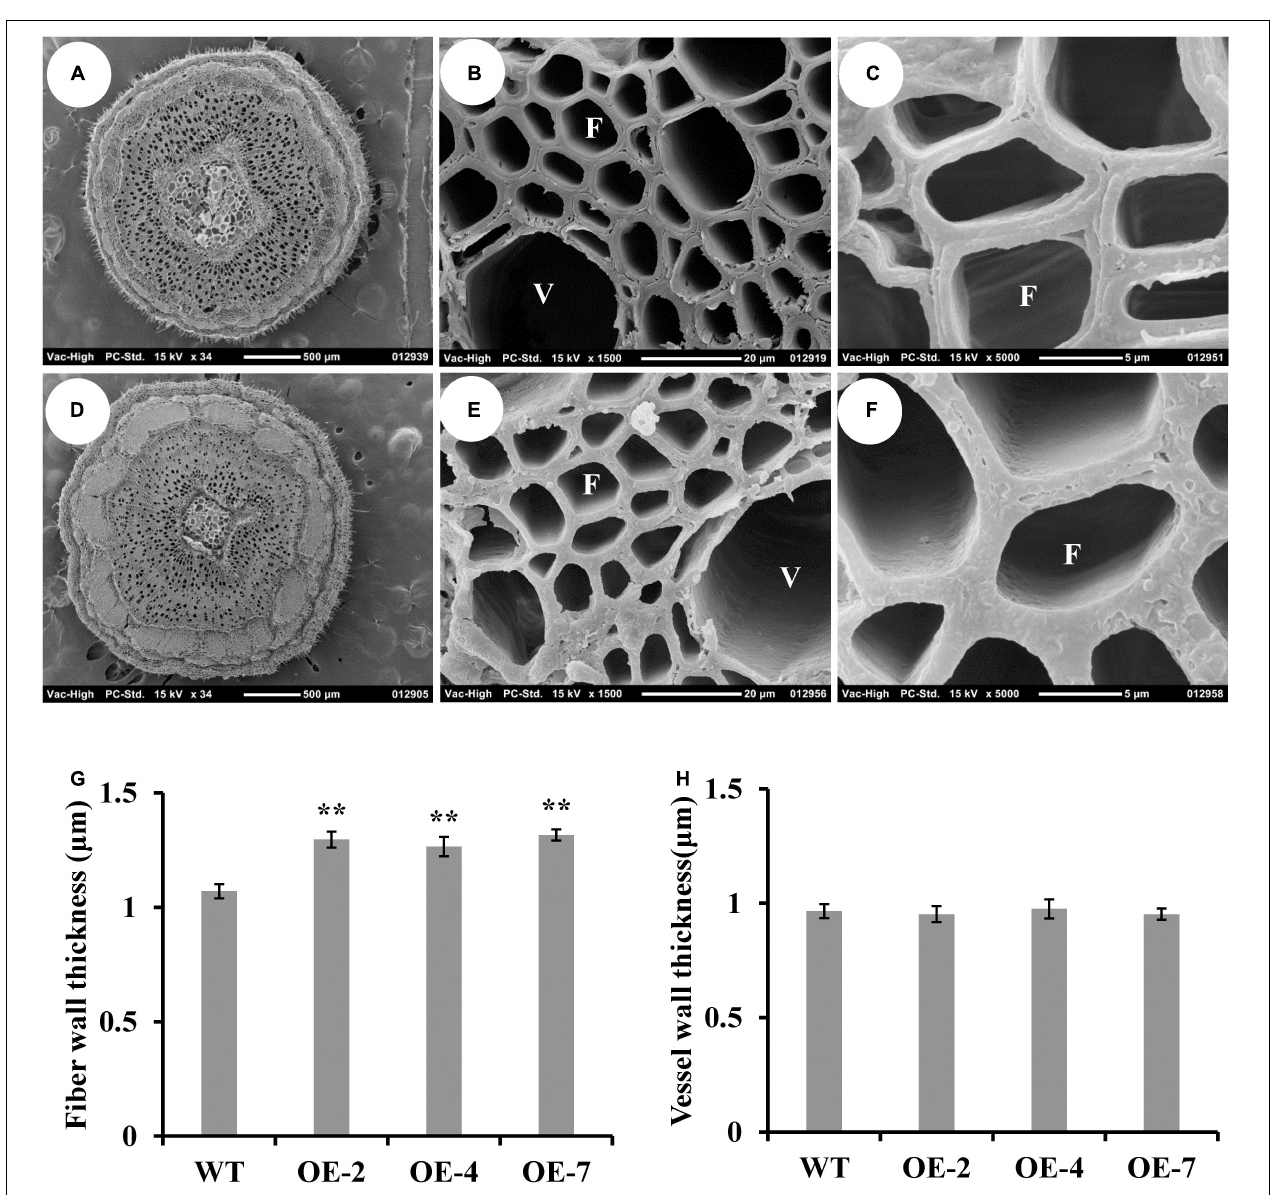
FIGURE 3 | Effect of PtrWOX13A overexpression on the secondary wall thickness of stems in Populus trichocarpa . (A–F) The scanning electron microscope of cross stem sections of wild type (A–C) and PtrWOX13A overexpression transgenic lines (D–F) . (A,D) represent 34 × , (B,E) represent 1,500 × , and (C,F) represent 5,000 × scanning electron microscope of cross stem sections, respectively. V and F in (B,C,E,F) represent vessel cell and fiber cell, respectively. (G) The fiber wall thicknesses of cross stem sections in wild type (WT) and PtrWOX13A overexpression transgenic lines (OE-2, OE-4, and OE-7). (H) The vessel wall thicknesses of cross stem sections in WT and PtrWOX13A overexpression transgenic lines. Error bars represent the standard deviation of three biological replicates. Asterisks indicate levels of significance (Dunnett’s test; ** p < 0.01). All data were measured on the 8th stem of 90-day-old